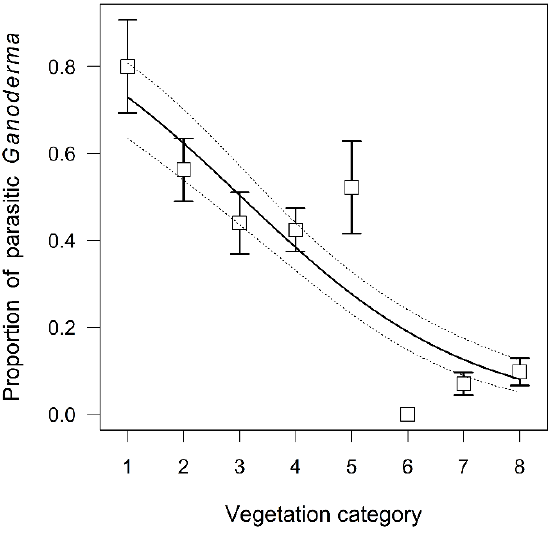
Figure 7. Proportion of parasitic Ganoderma samples along the vegetation category gradient (mean ± SE), the trend is predicted from binomial generalized linear model.